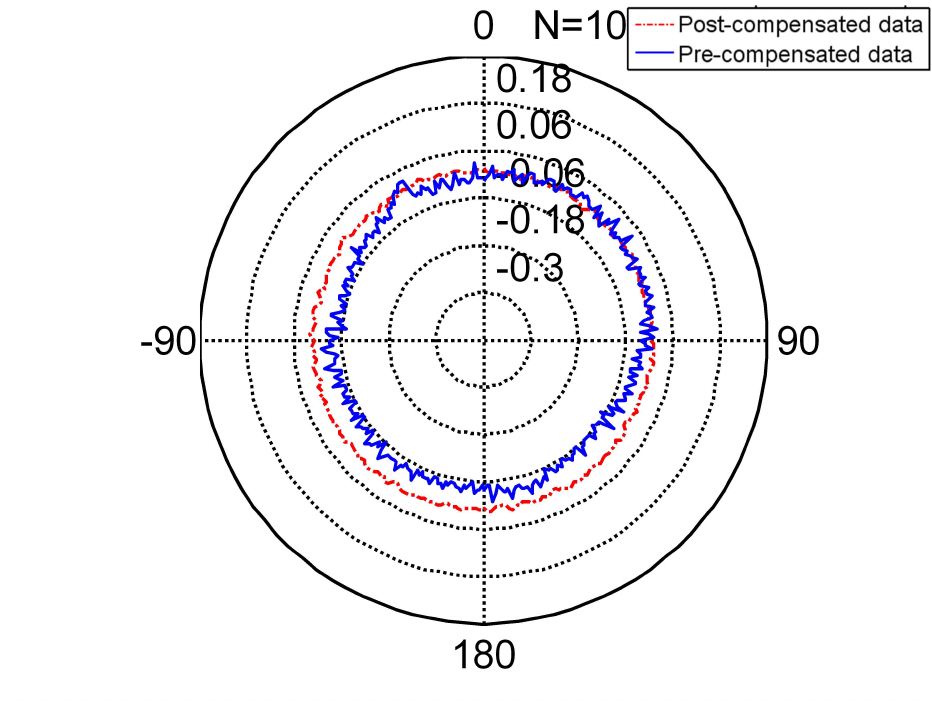
Figure 8. The pre-compensated and post-compensated data.